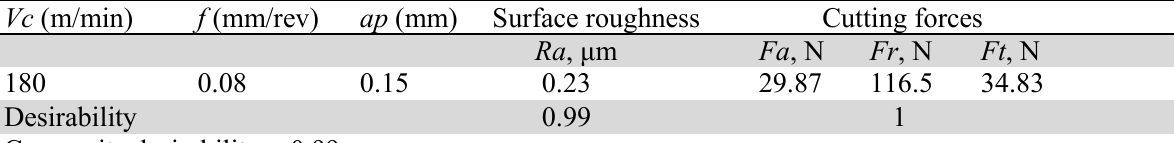
Response optimization for surface roughness and cutting force components.